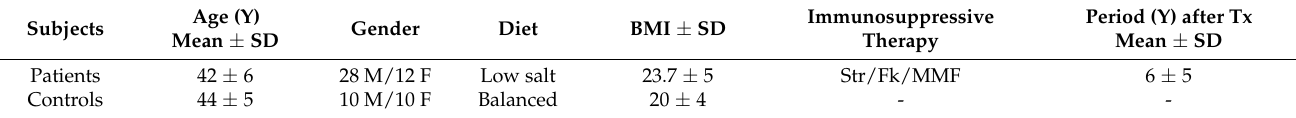
Table 1. Clinical and demographic data of study groups.